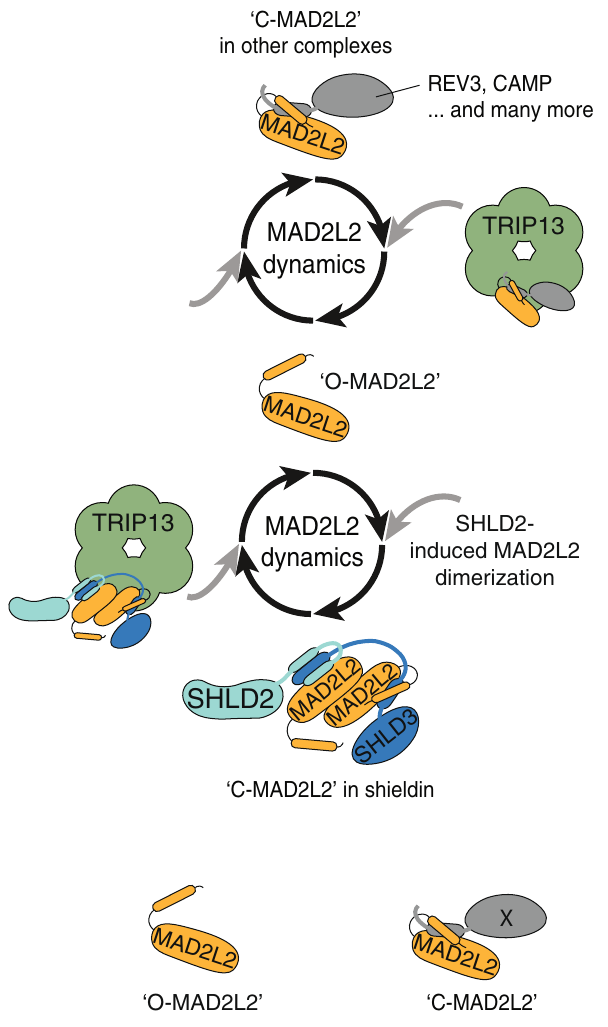
Fig. 7 Model of MAD2L2 dynamics. Model of how MAD2L2 dynamics is regulated by SHLD2-induced MAD2L2 dimerization and TRIP13-mediated opening of the MAD2L2 safety-belt and release of the entrapped peptide. MAD2L2 can interact with various proteins by entrapping a speci fi c peptide of its interacting partner with its C-terminal safety-belt, forming closed MAD2L2 ( “ C-MAD2L2 ” ). TRIP13 facilitates the opening of the MAD2L2 safety-belt, promoting release of the MAD2L2 partner protein and resulting in open MAD2L2 ( “ O-MAD2L2 ” ). TRIP13 might thereby contribute to the ability of MAD2L2 to shuttle between different protein complexes or promote disassembly of MAD2L2 protein complexes at the right place and